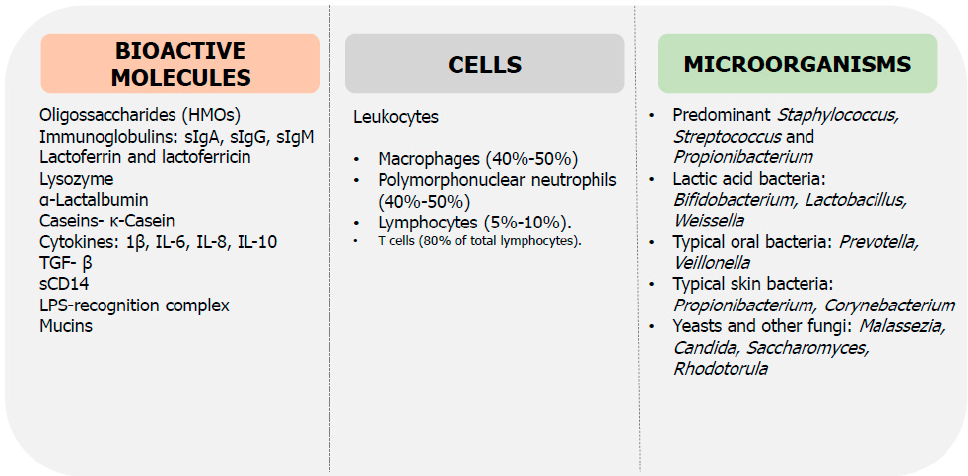
Figure 2. Selected microbial and immunological factors in breast milk (BM). sIg: secretory immunoglobulin, IL: interleukin, TGF: transforming growth factor, LPS: lipopolysaccharide.